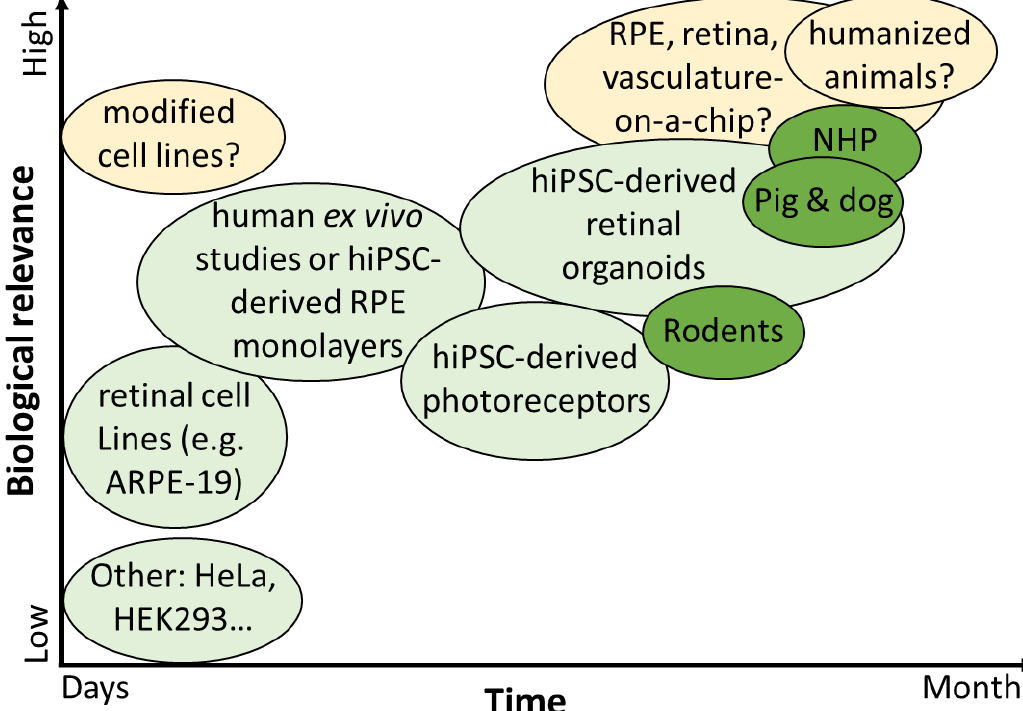
Figure 6. Qualitative assessment of biological relevance and time of assay for retina-specific rAAV potency assay models. Abbreviations: hiPSC, human induced pluripotent stem cell; NHP, non-human primates; RPE, retinal pigment epithelium.